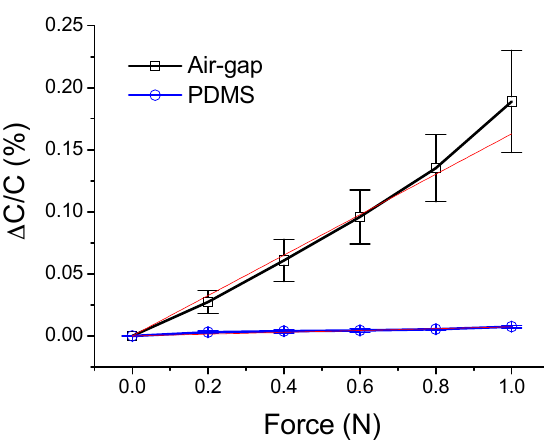
Figure 10. Relationships between the force and capacitance of the air-gap and PDMS touch sensors.